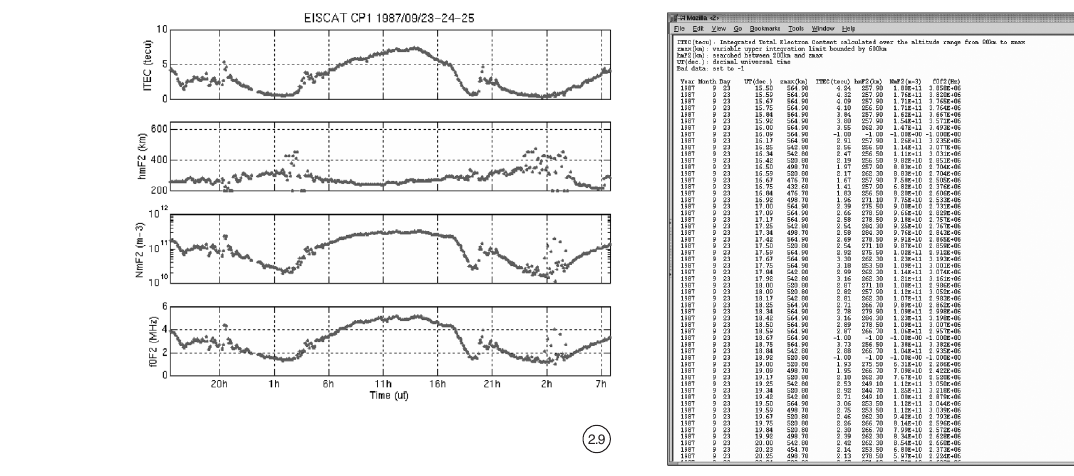
Fig. 2.9. Plotting data from the EISCAT database. Fig. 2.10. Listing data from the EISCAT